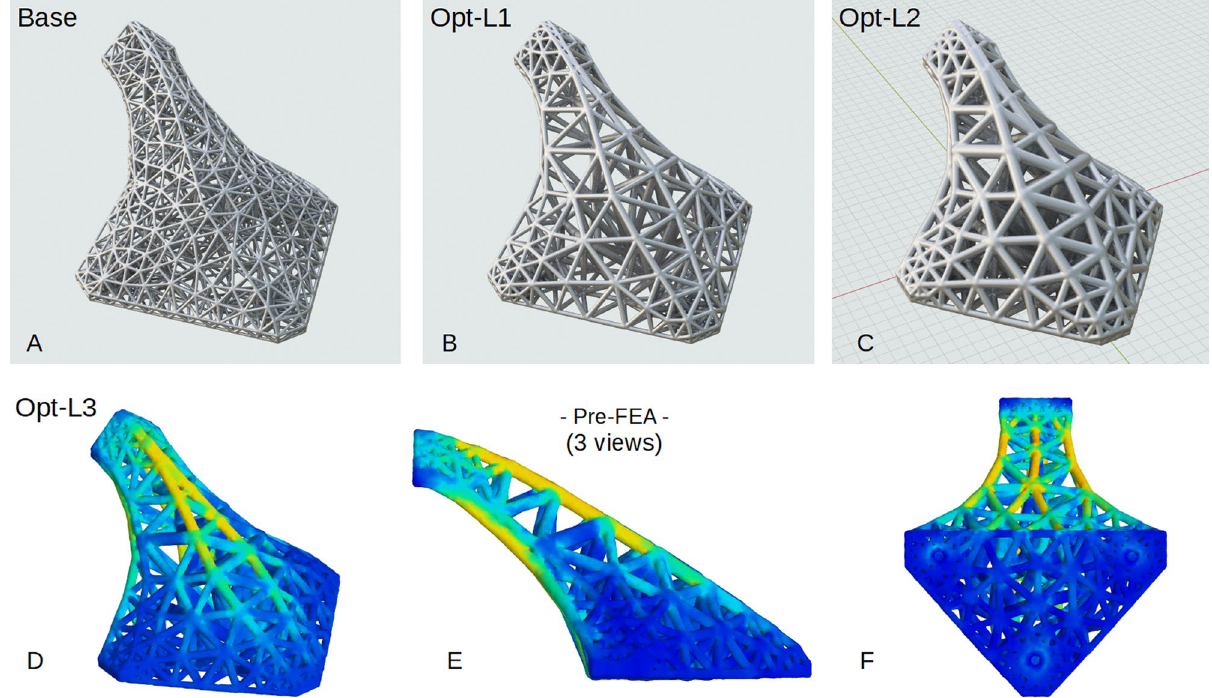
Figure 15. Stress optimized meta-structure starting with ( A ) initial ‘base’ HGon, ( B ) first density optimization, ( C ) second iteration, and ( D – F ) three views of the L3 final iteration. Struts and joints are thickened, thinned, or removed in accordance with stresses computed from the pre-FEA with for this study a simple + Z axis 100 N applied load. Other loading combinations can be applied which would result in a different final HGon adapted/ optimized structure.